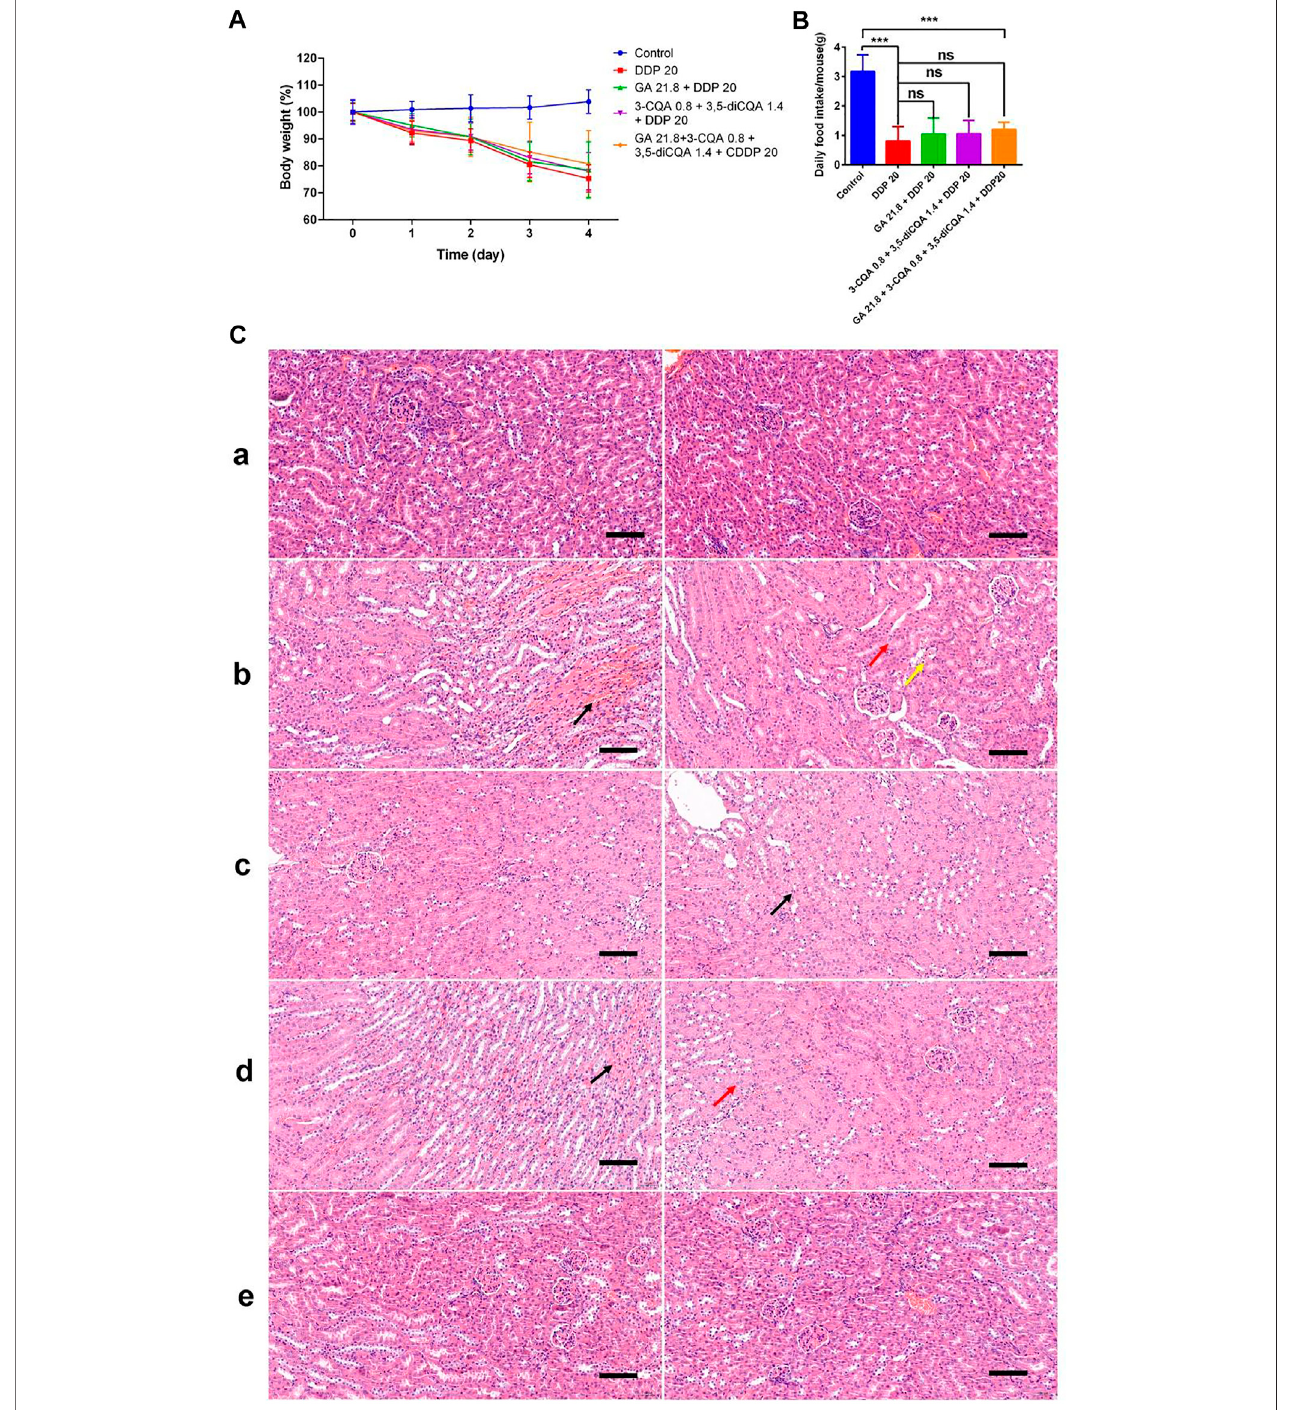
FIGURE 11 | The effect of two Chinese medicine formulas on the nephrotoxicity induced by DDP. (A) Body weight of mice in different groups. (B) Food intake of miceindifferentgroups.Themeanvalue±standarderrorisshowninthe fi gure( n =5).Thebodyweightisrepresentedasmean±SEM.The p valuesweredeterminedby Student ’ s t test (* p < 0.05, ** p < 0.01, *** p < 0.001). (C) Representative H&E staining of kidney sections in mice after DDP chemotherapy. (A) control; (B) DDP group; (C) DDP + GA group; (D) DDP+3-CQA+3,5-diCQA group; and (E) DDP+3-CQA+3,5-diCQA + GA group.